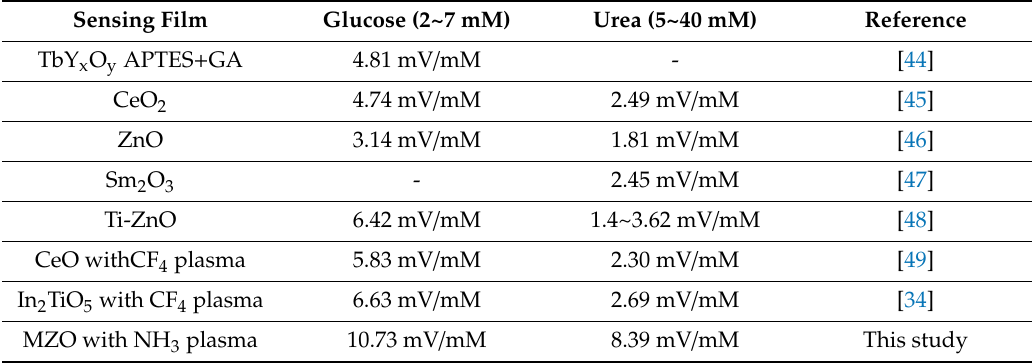
Table 1. Comparison of obtained parameters for glucose and urea sensing amongst di ff erent EIS